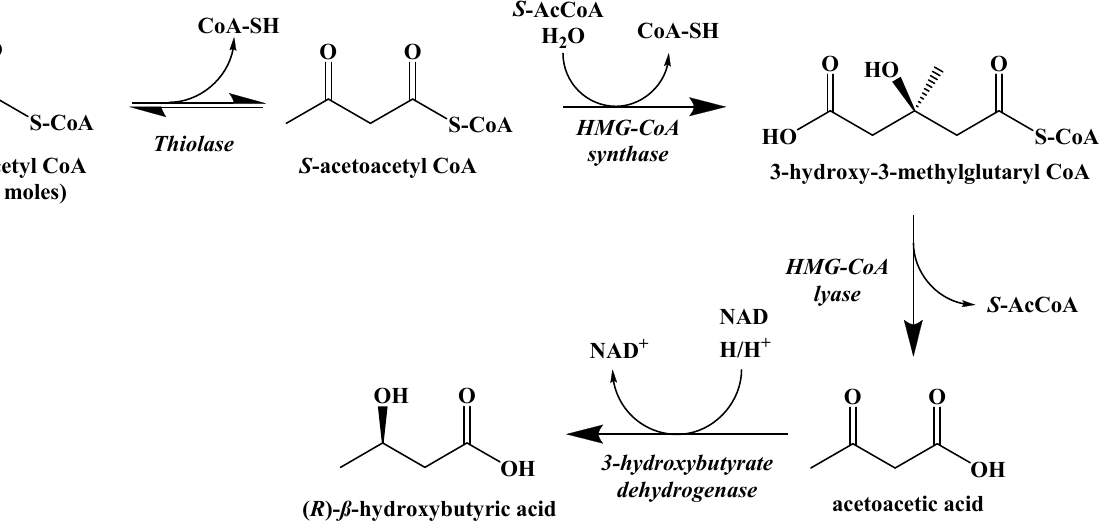
Figure 12. Ketogenesis of Ketone Bodies from S-Acetyl CoA.